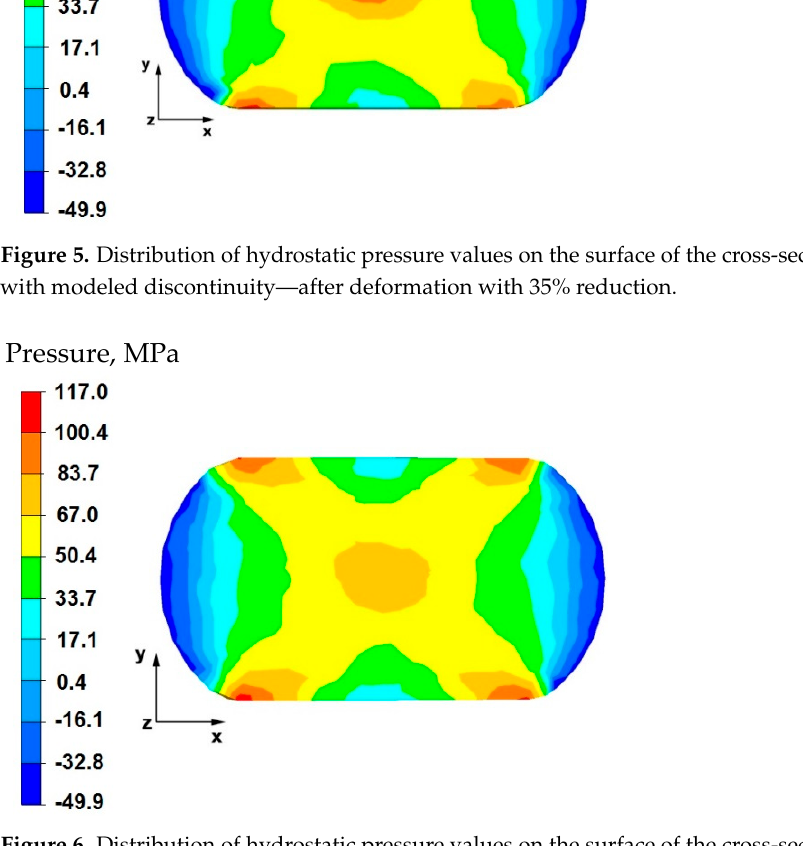
Figure 6. Distribution of hydrostatic pressure values on the surface of the cross-section of the sample without modelled discontinuity—after deformation with 35% reduction.